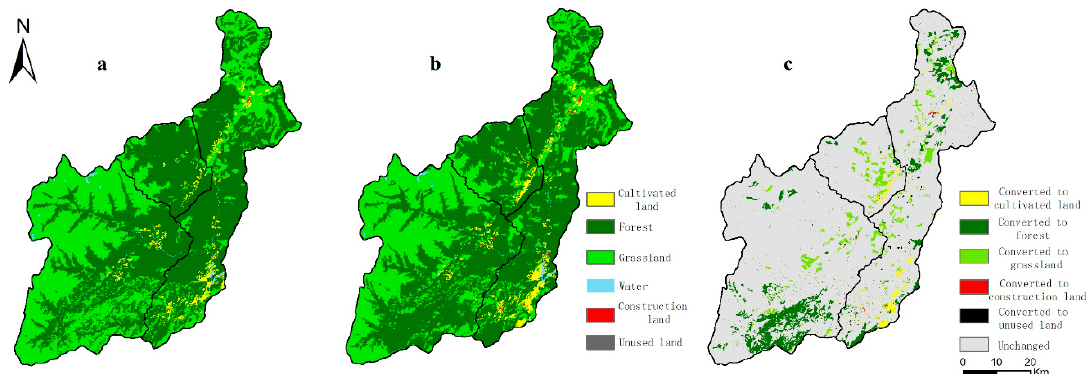
Figure 3. Land transformation from 2000 to 2015: ( a ) land type in 2000, ( b ) land type 2015, and ( c ) land transformation from 2000 to 2015.